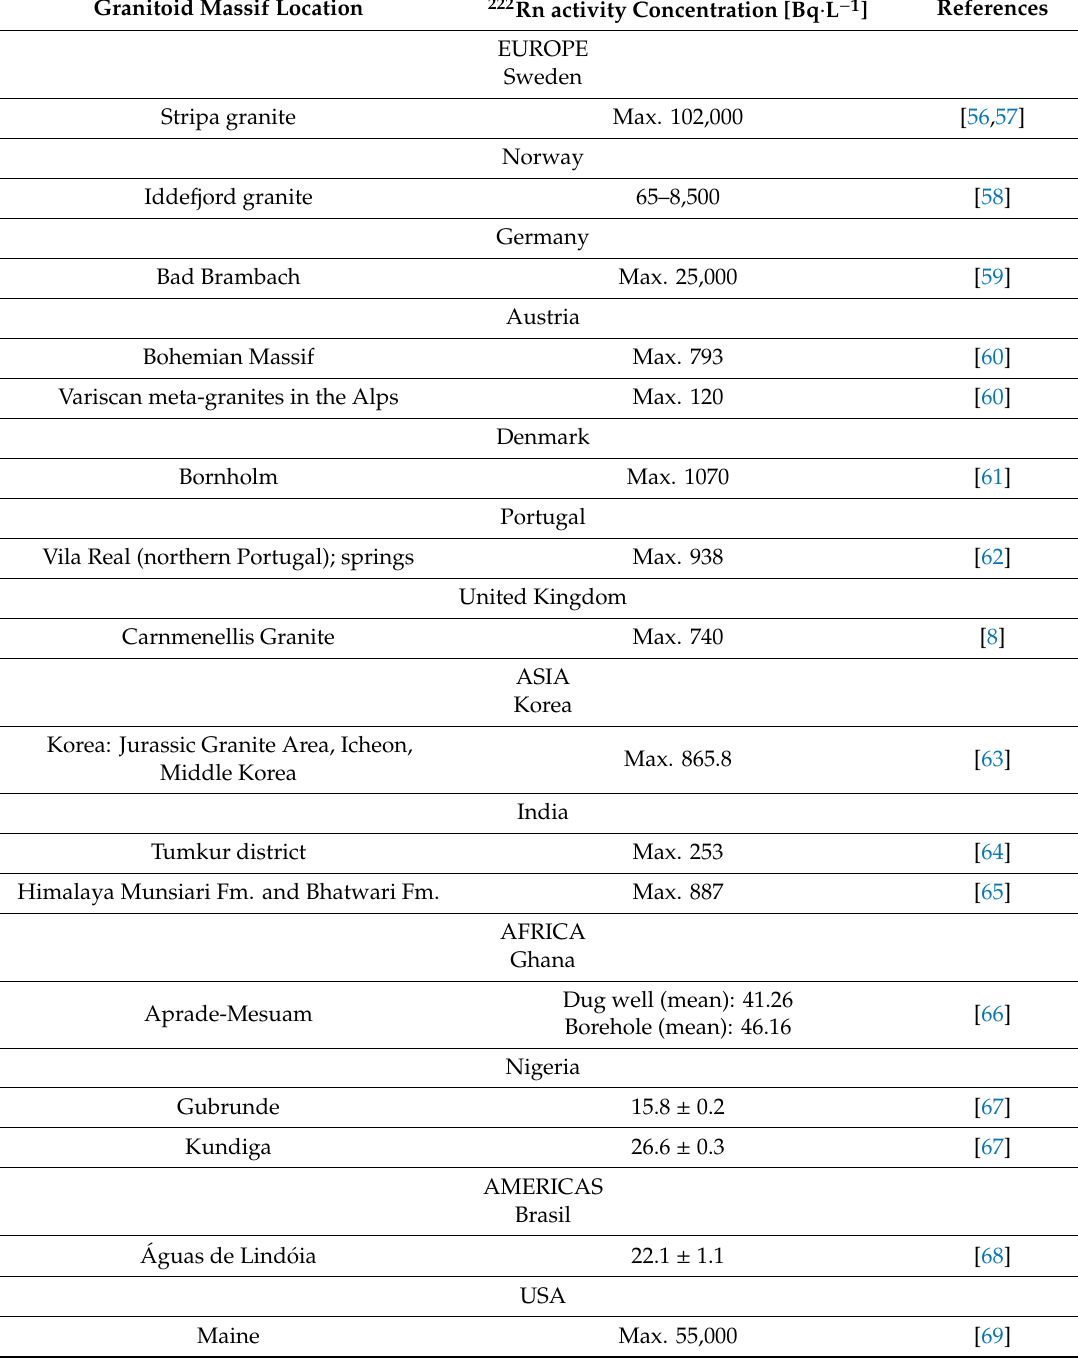
Table 4. 222 Rn activity concentration in groundwaters from selected granitoid massifs of the world. Granitoid Massif